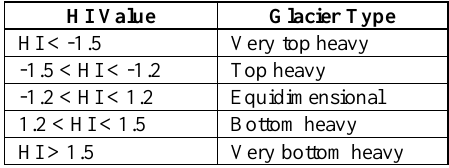
Table 2. Glacier type based on HI value